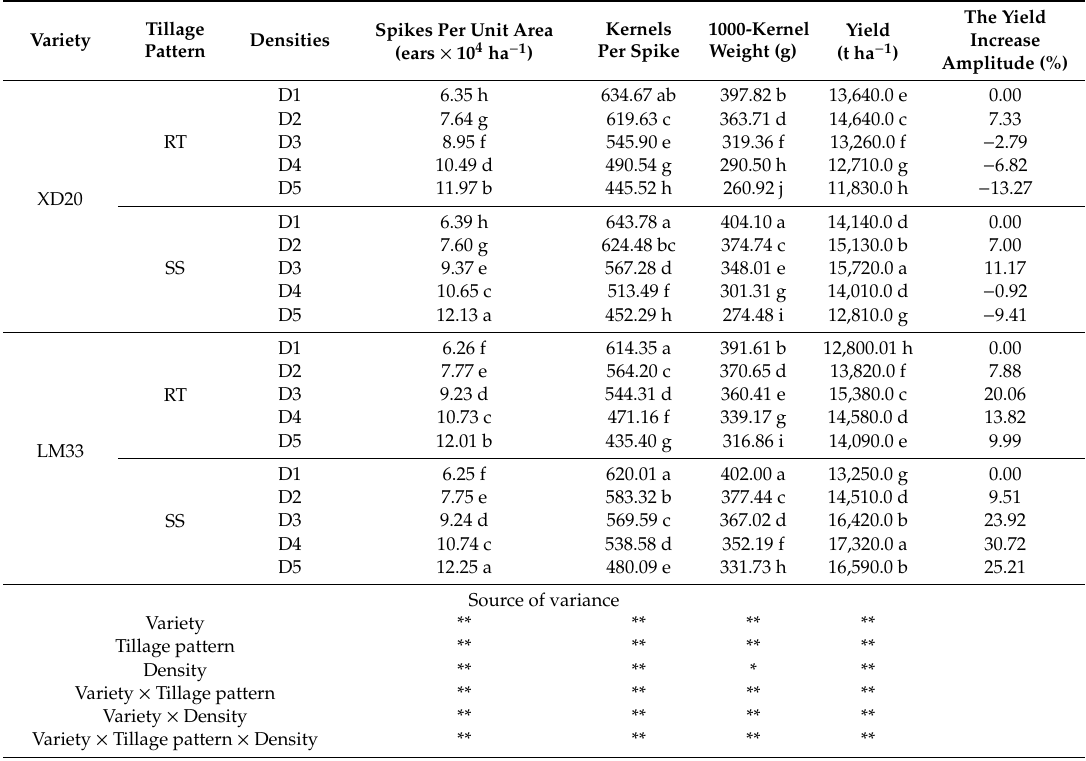
Table 2. Grain yield and yield components of di ff erent high-yielding spring maize varieties under di ff erent tillage methods and planting